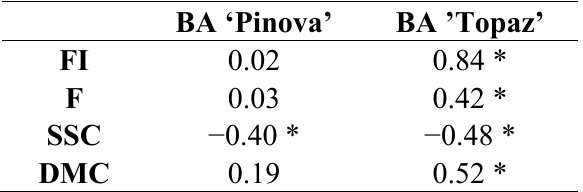
Table 4. Pearson’s correlation coefficients ( R ) for the correlation between biospeckle activity (BA) and other quality attributes (F–firmness, FI–firmness index, SSC–soluble solids content, DMC–dry matter content), measured for ‘Pinova’ and ‘Topaz’ apples. Asterisks denote significance at p <